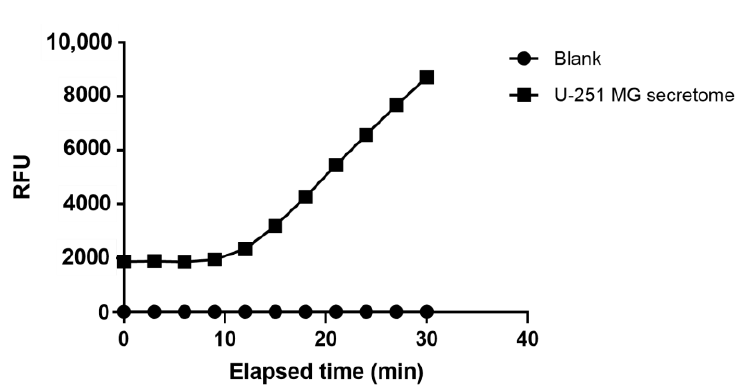
Figure A1. Furin substrate proteolytic cleavage by U-251 MG secretome. This figure compares proteolytic activity between the U-251 MG secretome and a blank solution of distilled water (the same medium as the solvent for the secretome). RFU: relative fluorescence units; min : minutes.